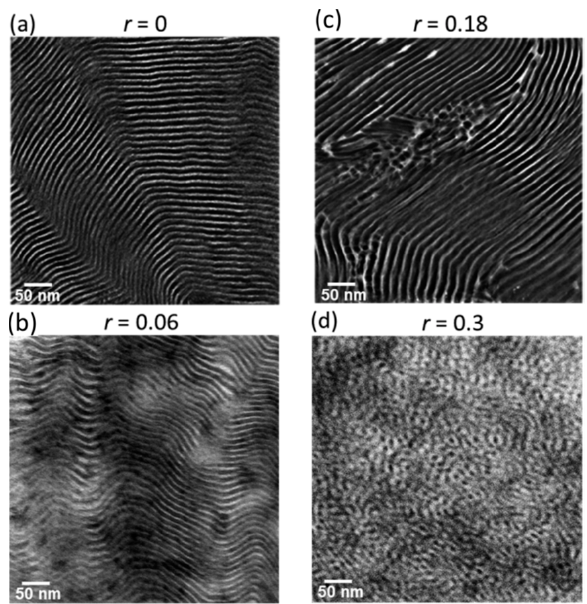
Figure 8. Dark-field transmission electron microscopy images of SEO(16 − 16) at ( a ) r = 0 and ( c ) r = 0.18, reproduced from [68] and at ( b ) r = 0.06 and ( d ) r = 0.3 measured in this work. The bright phase is poly(ethylene oxide) [65]. Reprinted with permission from [65]. Copyright 2018 American Chemical Society.